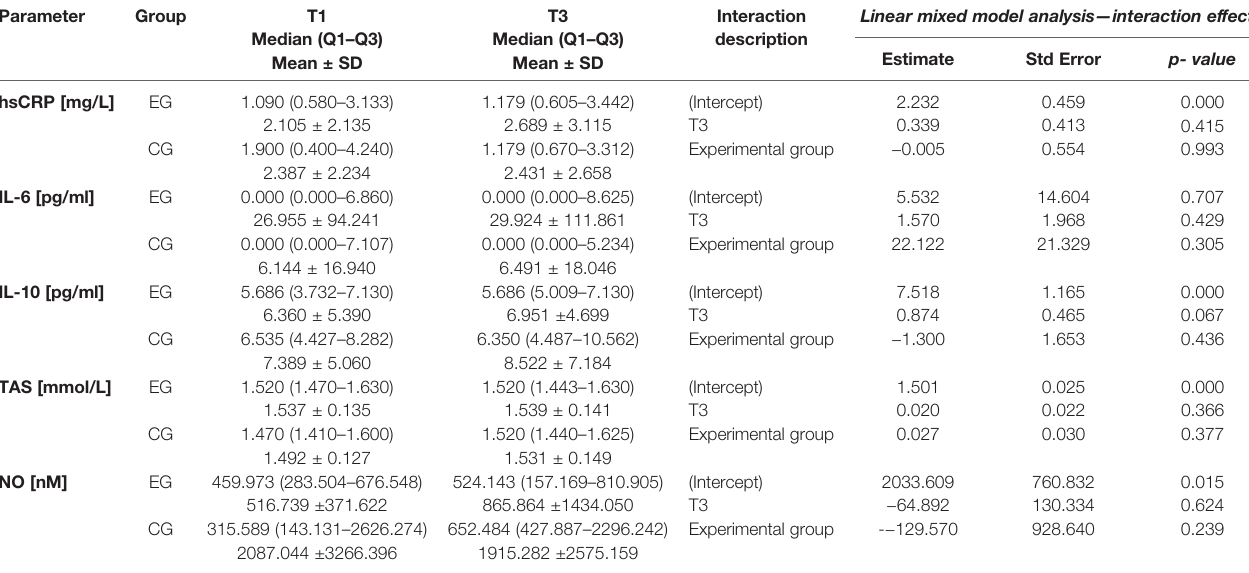
TABLE 5 | Biochemical results in blood before and after WBC (T1 vs. T3): hsCRP, TAS, IL-6, IL-10, and NO in experimental and CGs.